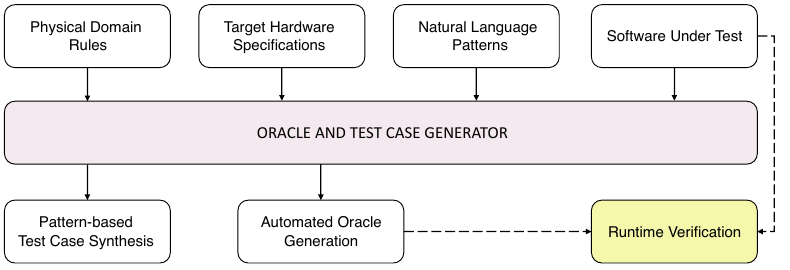
Figure 5. Architecture of the proposed automated test case and oracle generation system. The gener- ated oracle is incorporated into the SUT for runtime verification on the target